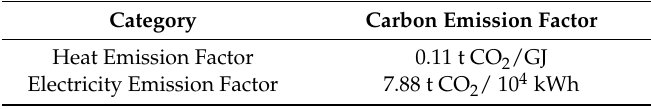
Table 4. Carbon emission factors for heat and electricity